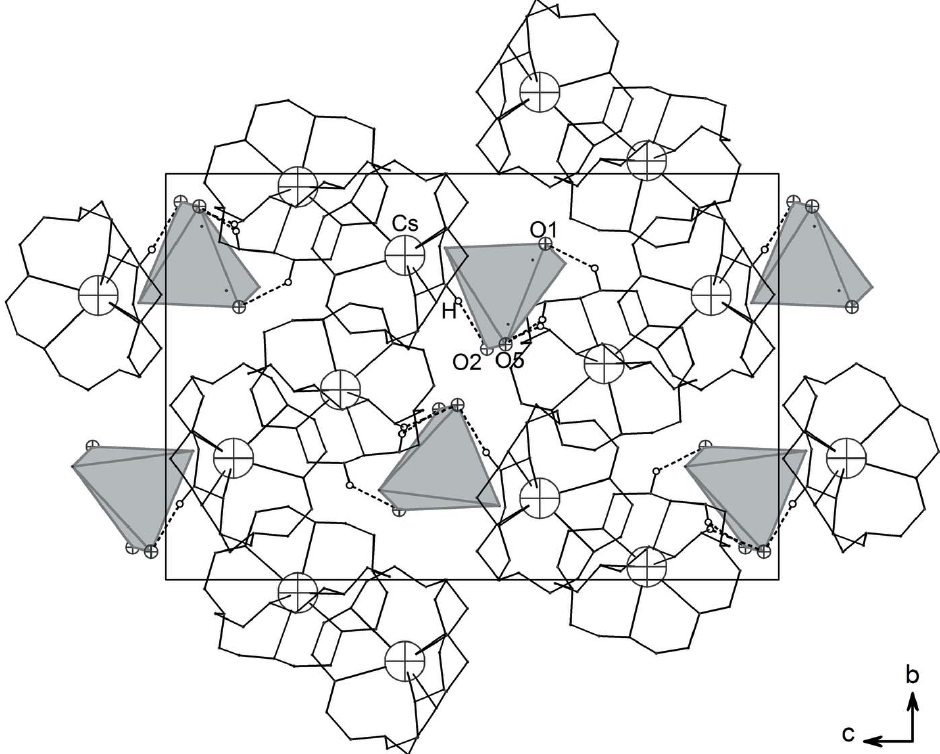
Figure 2 The crystal structure of [Cs([2.2.2]crypt)] 2 [Mo(CO) 5 ] in a projection onto the bc plane, including the shortest C—H (cid:5)(cid:5)(cid:5) O hydrogen bonds. [Mo(CO) 5 ] 2 (cid:2) anions are drawn as polyhedra and hydrogen bonds as dashed lines.